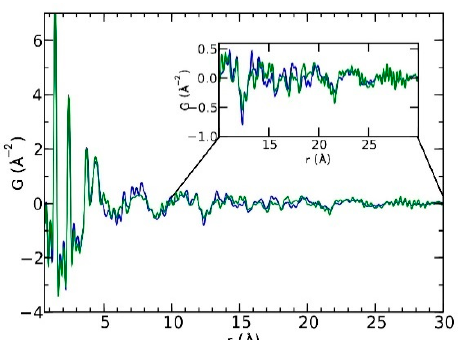
Figure 10. Comparison of the PDF data from the amorphous carbamazepine (CBZ) prepared by melt (green) and crystalline CBZ form III (blue). Republished with permission of Royal Society of Chem-